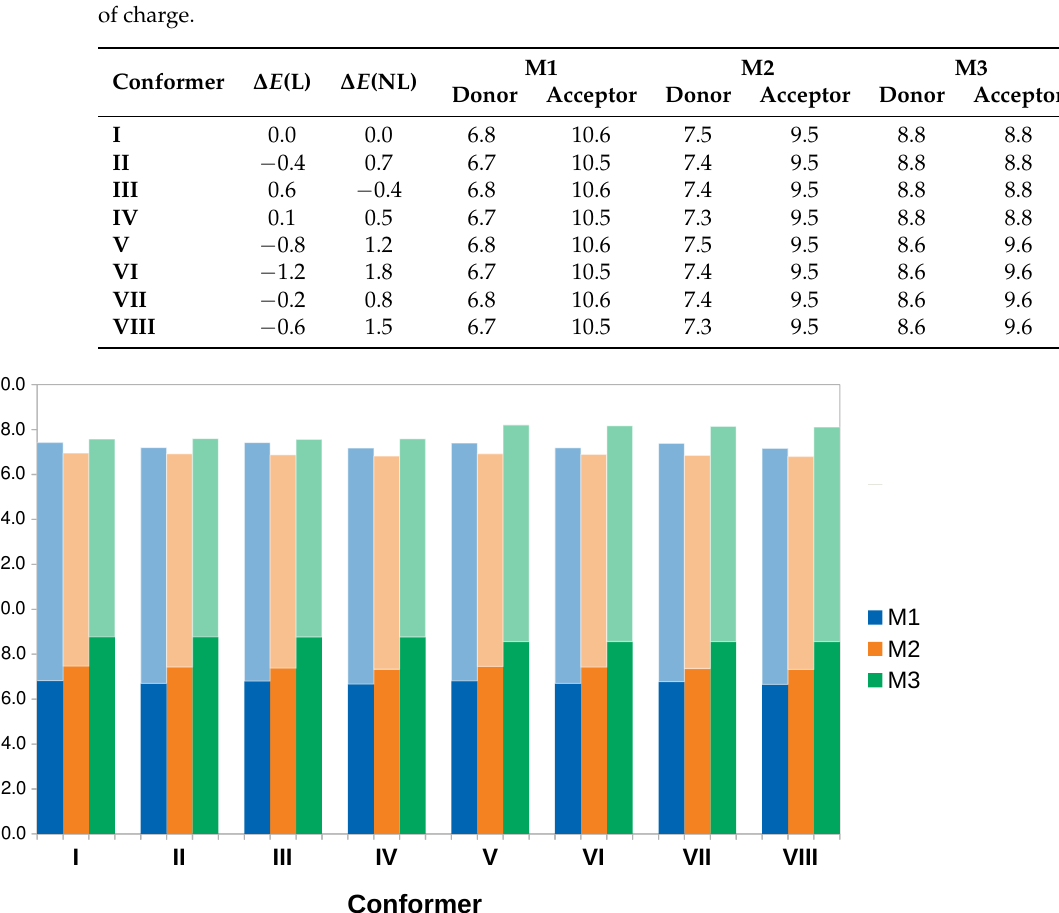
Table 2. Energy of NBO deletions in kcal/mol for all conformers of caffeine in Figure 2. Indiscriminate